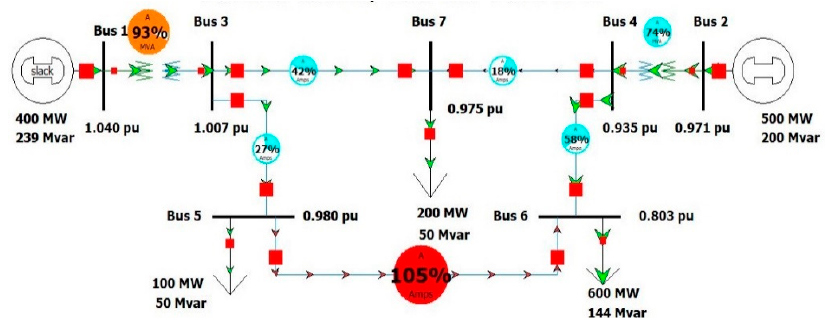
Figure 18. Power flow of 7 bus system after load increment at bus 6.